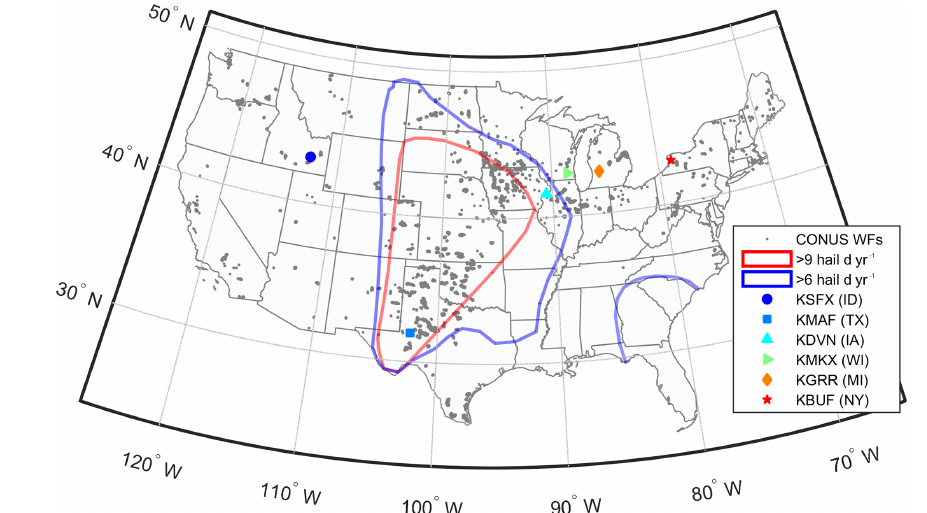
Figure 1. Locations of wind turbines as deployed at the end of 2017 according the USGS database (available from https://eerscmap.usgs. gov/uswtdb/, last access: 15 January 2020; USGS, 2018) (grey dots), the NWS radar stations from which data are presented (see details in Table 1) and areas of frequent hail occurrence. Areas with more than 9hail days per year are outlined by the red contour, and those with more than six are outlined by the blue contours (Cintineo et al., 2012).